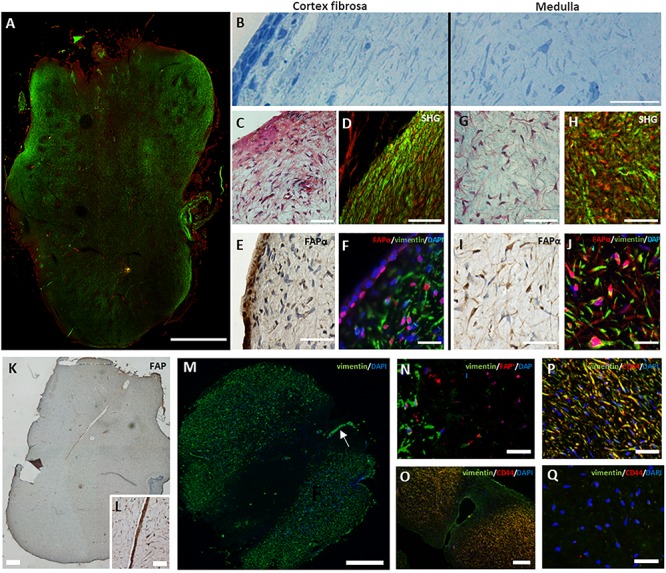
Heterogeneous expression of FAPα in the apical papilla. (A) Tile scan of a second harmonic generated overview of a complete apical papilla (green, collagen type I; red, autofluorescence). (B) Semi-thin section of an apical papilla stained with toluidine blue showing a parallel orientation of cells at the cortex fibrosa but random orientation inside the medulla. (C) Masson’s Trichrome staining of the cortex fibrosa showing a high collagen concentration. (D) Second harmonic generation imaging of the periphery of the apical papilla (green, collagen type I; red, autofluorescence). (E) DAB staining for FAPα reveals a heterogeneous expression pattern at the periphery of the tissue. Note the marked staining of FAPα in the epithelial region. (F) Double immunofluorescent staining showing predominantly vimentin positive cells (green) and a small population of FAPα+ (red)/vimentin+ cells. The epithelial region consists of FAPα+ but vimentin– cells. (G) Masson’s Trichrome staining of the medulla reveals a loose extracellular matrix with spindle-shaped cells. (H) Second harmonic imaging confirms the loose collagen distribution (green). (I) DAB staining indicates high expression levels of FAPα in the medulla. (J) Immunofluorescent staining reveals a predominant population of FAPα+ (red)/vimentin+ (green) cells. (K) FAPα expression in the dental nerve (K, magnification in L). (M) Immunofluorescent staining showing absence of vimentin staining in the inner medulla. Note the presence of the vimentin positive nerve (M, arrow). (N) Double immunofluorescent staining showing vimentin negative but FAPα positive cells (red) in the inner medulla. (O–Q) Double immunofluorescent staining of vimentin (green) and CD44 (red) reveals double positive cells in the outer medulla (yellow) but complete absence of staining in the inner medulla. Scale bars represent 25 (F,J,O,P,Q,N), 50 (B,C,D,E,G,H,I,L), 100 (J), 250 (K,M), and 1000 (A) μm.